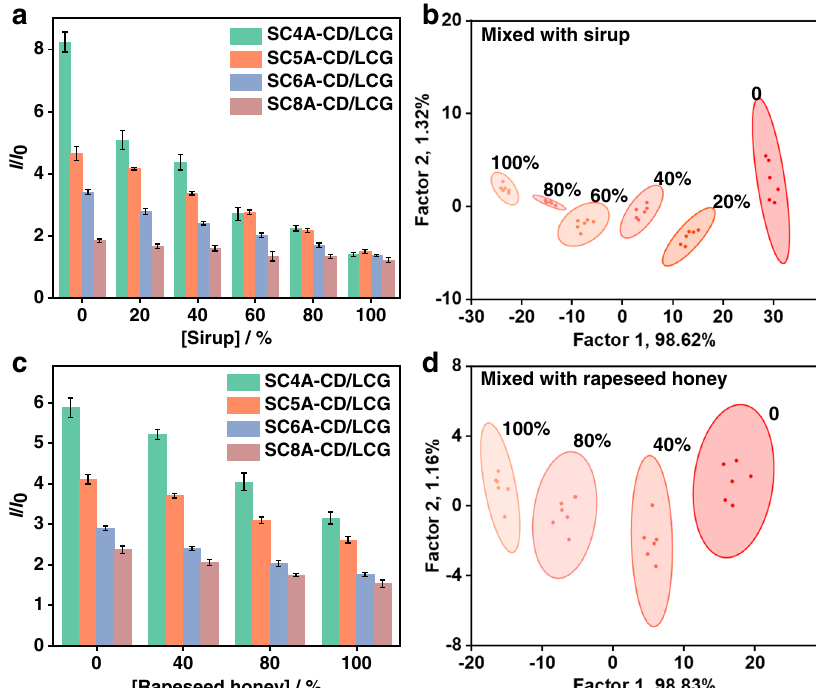
Fig. 9 Discrimination of honey samples mixed with sirup or cheaper honey. a Fluorescence response patterns and b canonical score plot against mixtures of honey and sirup. c Fluorescence response patterns and d canonical score plot against mixtures of honey and sirup against mixtures of vitex and rapeseed honey (3.0 mg/mL for each mixture sample). Pattern recognition of honey samples using SA11 ([CA] = [CD] = 1.0 μ M, [LCG] = 1.0 μ M). Canonical score plots for the two factors of simpli fi ed fl uorescence response patterns obtained from LDA with 95% con fi dence ellipses. Error bars in a , c represent mean ± s.d. ( n = 6 independent experiments). The order of colored symbols from top to bottom in the legend corresponds to the column order of histogram from left to right in a , c